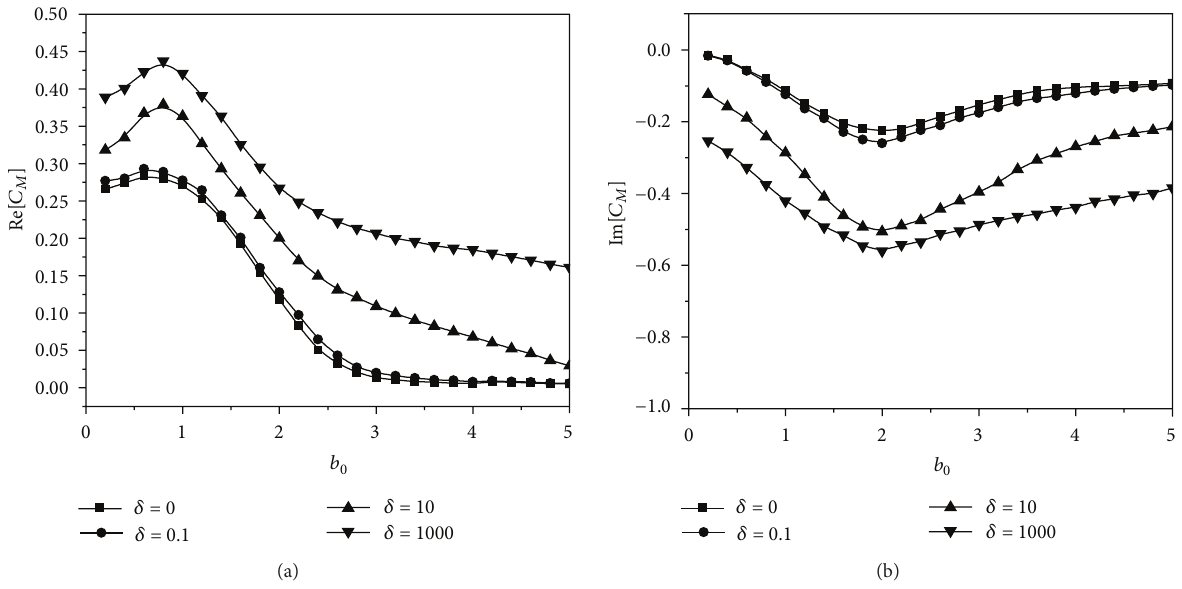
Figure 4: The dynamic compliance coefficient 𝐶 𝑀 for different 𝛿 . (a) Real part of 𝐶 𝑀 versus the dimensionless frequency and (b) imaginary part of 𝐶 𝑀 versus the dimensionless